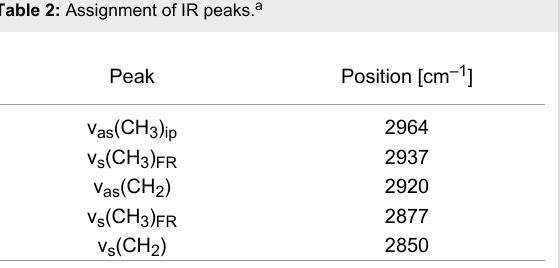
Table 2: Assignment of IR peaks. a